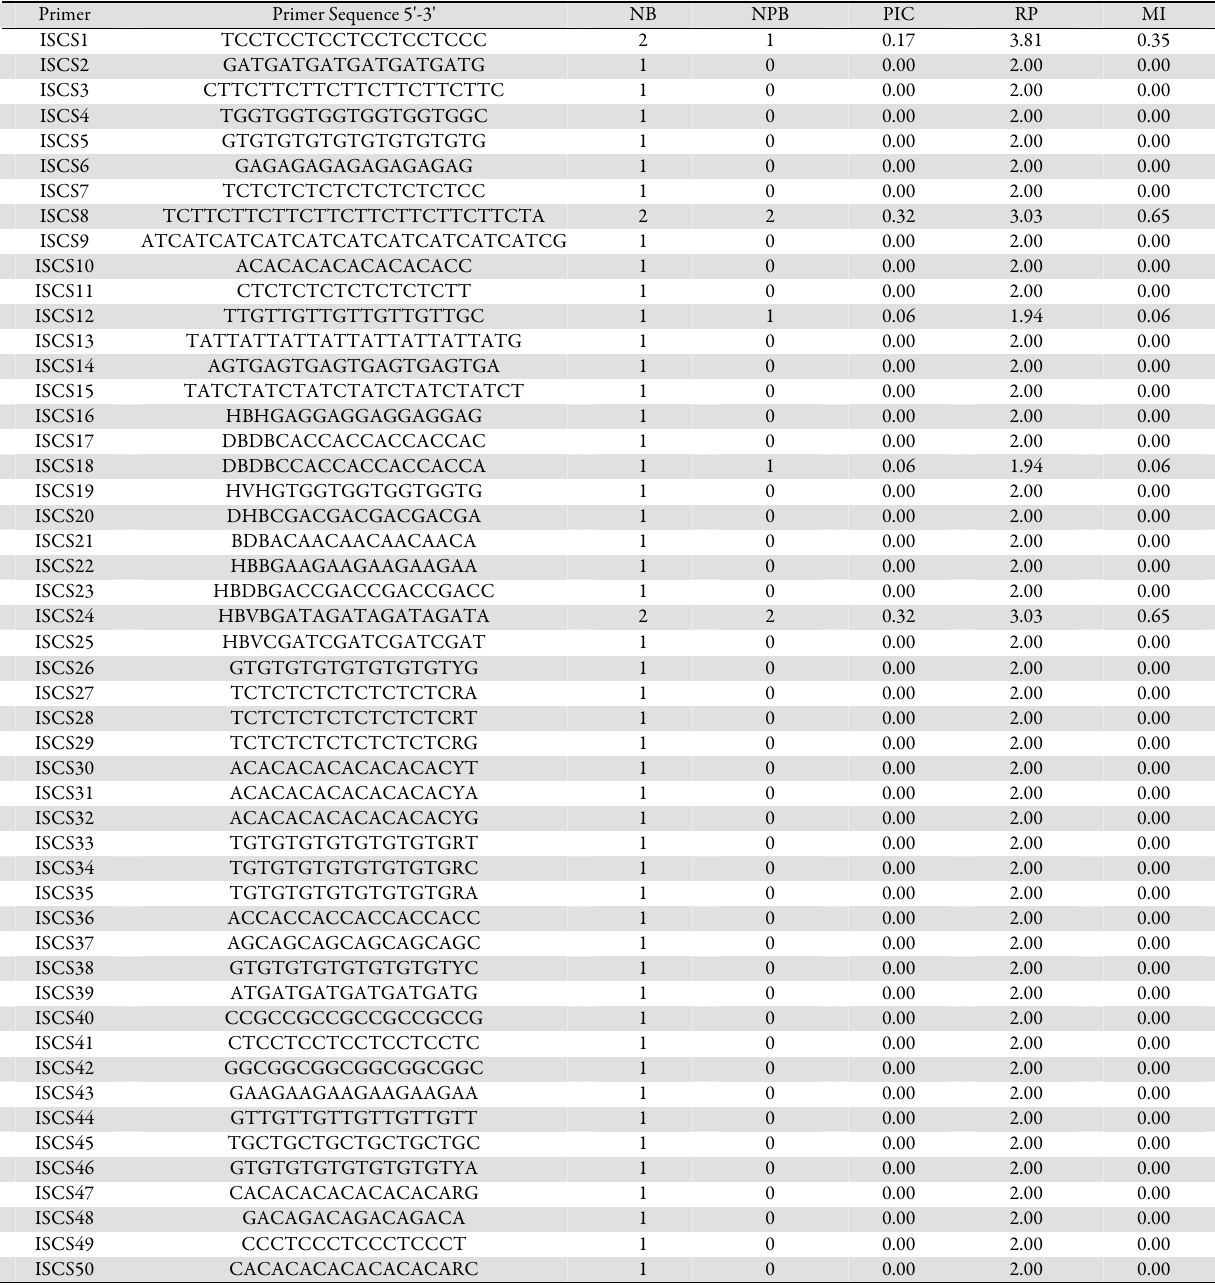
Table 3. Polymorphic profile of 50 ISSR primers across 31 selections of saffron